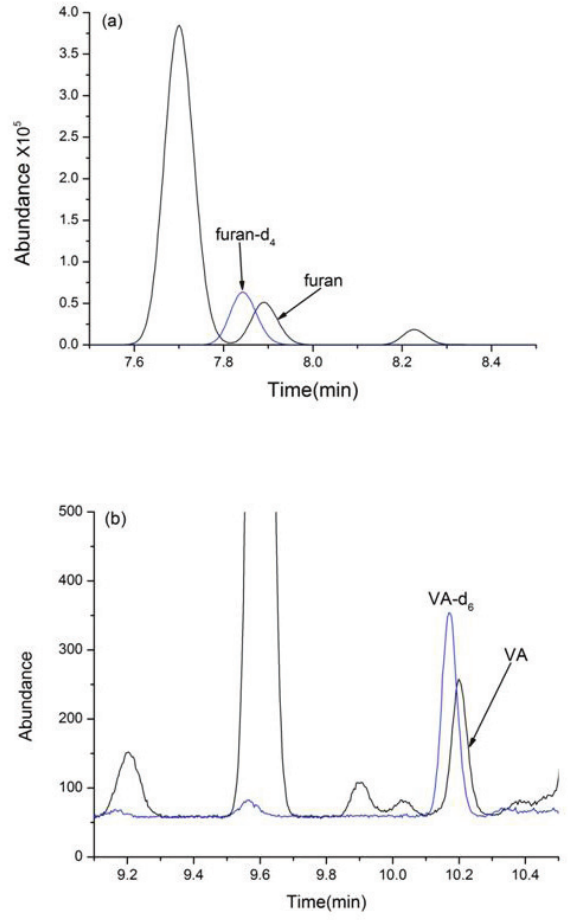
Figure 1- GC-MS chromatograms of furan (m/z = 68), furan- d (m/z = 72) (a) and VA(m/z = 86), VA- d phase of mainstream cigarette smoke